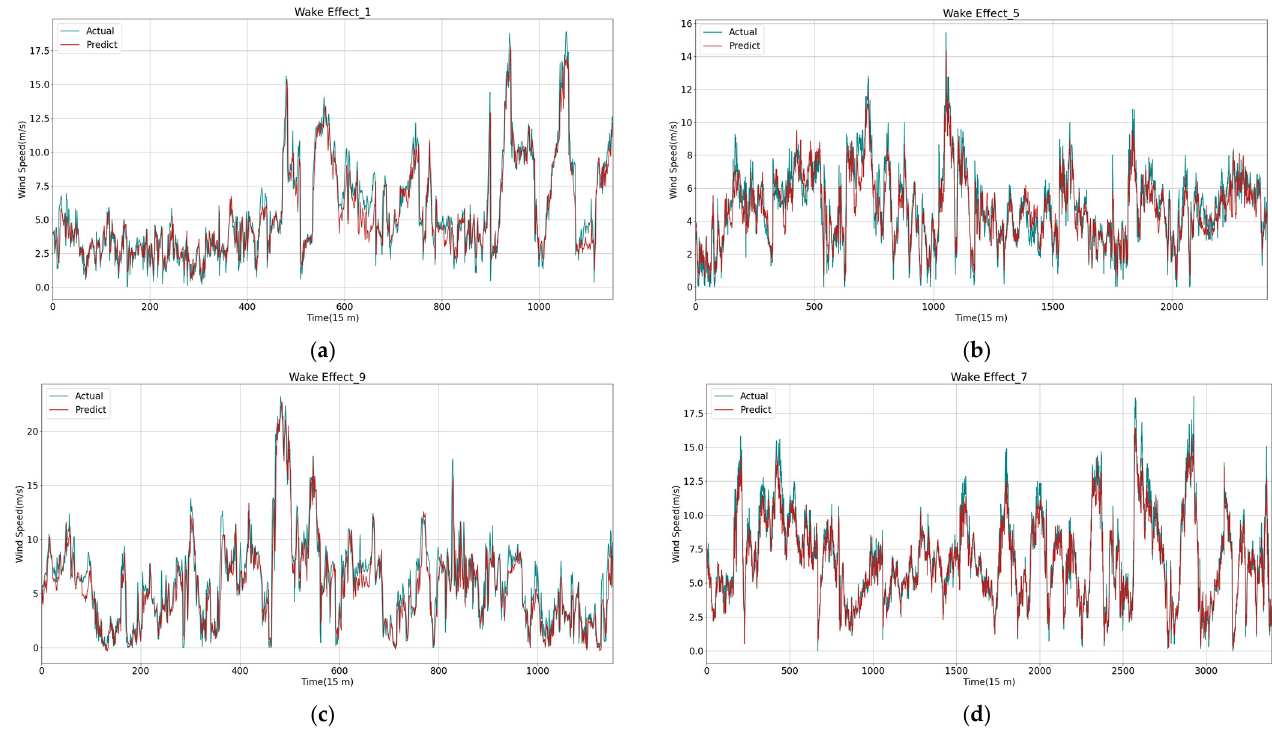
Figure 9. Wind turbines affected by wind turbine No. 6 (by direction): ( a ) prediction of wake effect for No. 1 wind turbine by machine learning (N direction); ( b ) prediction of wake effect for No. 5 wind turbine by machine learning (E direction); ( c ) prediction of wake effect for No. 9 wind turbine by machine learning (S direction); ( d ) prediction of wake effect for No. 7 wind turbine by machine learning (W direction). Table 6. Comparison of wake error caused by wind turbine No.